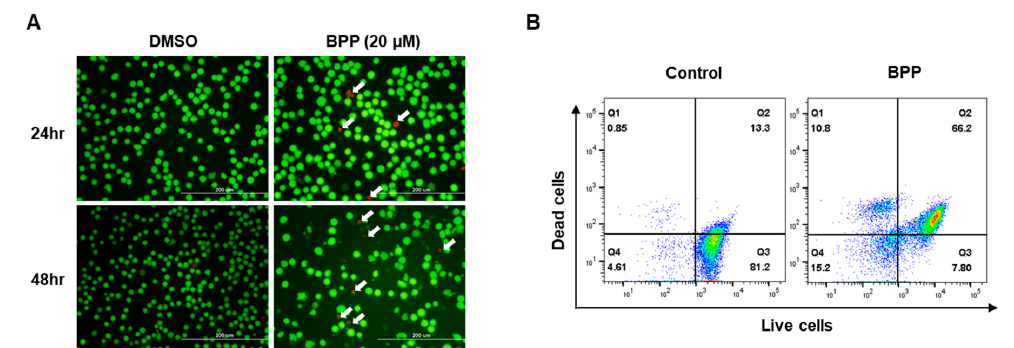
Figure 9. Measuring BPP-treated Jurkat cell viability. ( A ) Merged fluorescence images showing untreated and 48 h BPP-exposed Jurkat cells (green fluorescence, live cells; red fluorescence, dead cells). ( B ) Flow cytometry analysis of live and dead Jurkat cells with calcein and ethidium homodimer-1